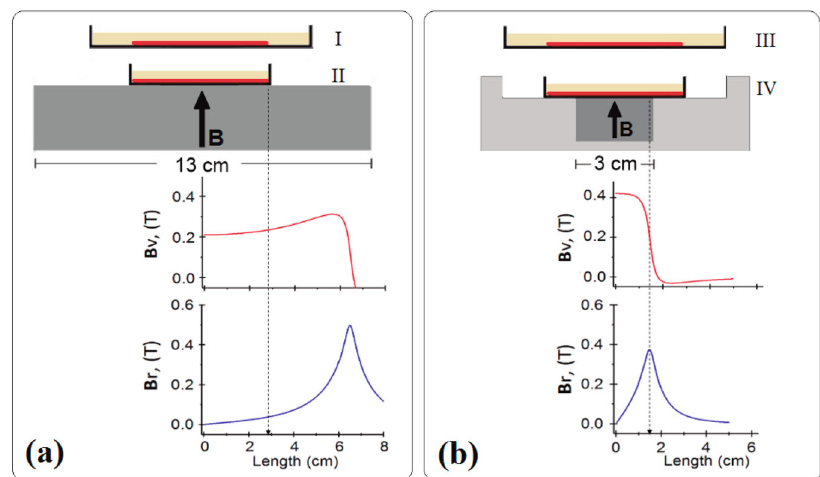
Fig. 8 Experimental setups for corrosion in presence of magnetic fi eld. a Schematic drawing of the experimental setups for the BMBC (I) and BMSC (II). b for the SMBC (III) and SMSC (IV). The graphics show the calculated vertical ( B v-red lines) and radial ( B r-blue lines) components of the magnetic fi the corrosive medium changed from light yellow to green-brown opaque color (according to the corrosion rate). The corrosion reactions were carried out at 25 ± 2 °C and were monitored up to 300 min, using digital (cell phone or Gopro Hero 4) cameras 13,14,34 – 36 . The Gopro camera was preferentially used, as it has a plastic protective housing, an important feature to monitor the experiments in harsh corrosive environments. The corrosion experiments were performed in the presence and absence of magnetic fi elds. The sources of magnetic fi elds were two cylindrical NdFeB permanent magnets named big magnet (BM) and small magnet (SM), with 130 mm in diameter and 25 mm in height and 30 mm diameter and 19 mm in height, respectively. Figure 8a shows the diagram for the big magnet-big cell — BMBC (I) and big magnet-small cell — BMSC (II). Figure 8b displays the diagram for the small magnet-big cell — SMBC (III) and small magnet-small cell — SMSC (IV) setups. The magnets (dark gray), Petri cells (black), CCL discs (red), and FeCl 3 solutions (light yellow) are schematically represented in Fig. 8. The light gray part at Fig. 8b (top) is a Te fl on piece that houses the small magnet and the cells. The graphics with red and blue lines are the calculated vertical ( B v) and radial ( B r) components of the magnetic fi elds, respectively. The dashed lines are used to guide the eyes and show that the CCL disc is in the homogenous region (Fig. 8a), which is crossed by the strongest magnetic fi eld components and MFGs in Fig. 8b. The B v red lines and B r blue lines were calculated at 2 mm (copper surface) above the magnet surface, using FEMM (Finite Element Method Magnetics, an open- source code found at https://www.femm.info/wiki/HomePage).